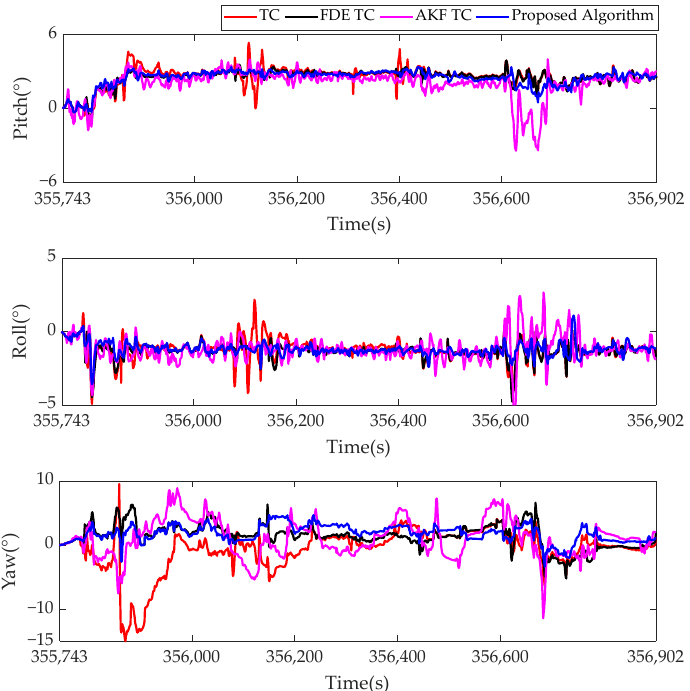
Figure 10. The altitude error of TC, FDE TC, AKF TC, and the proposed algorithm in field test. Table 4. The position RMSE of TC, FDE TC, AKF TC, and the proposed algorithm in field test. Algorithm